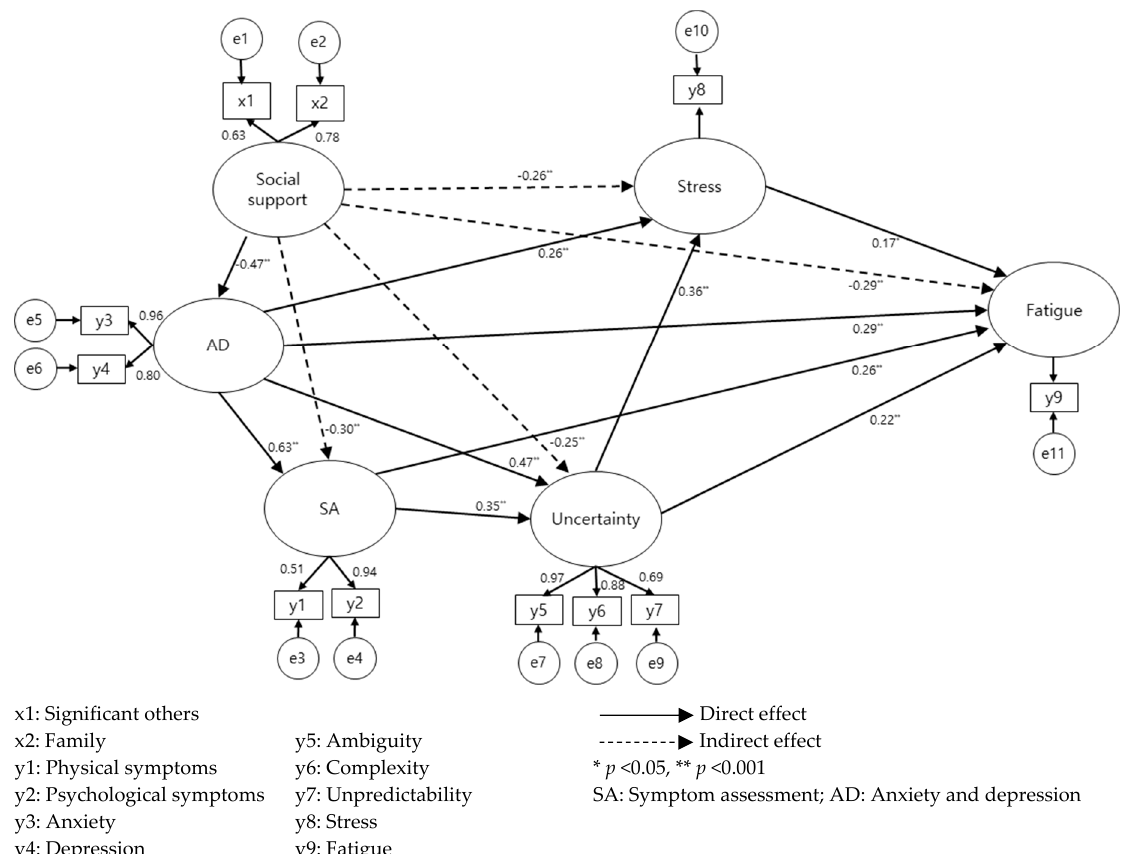
ff ect of path diagram of the structural Figure 2. The effect of path diagram of the structural model. Figure 2. The e